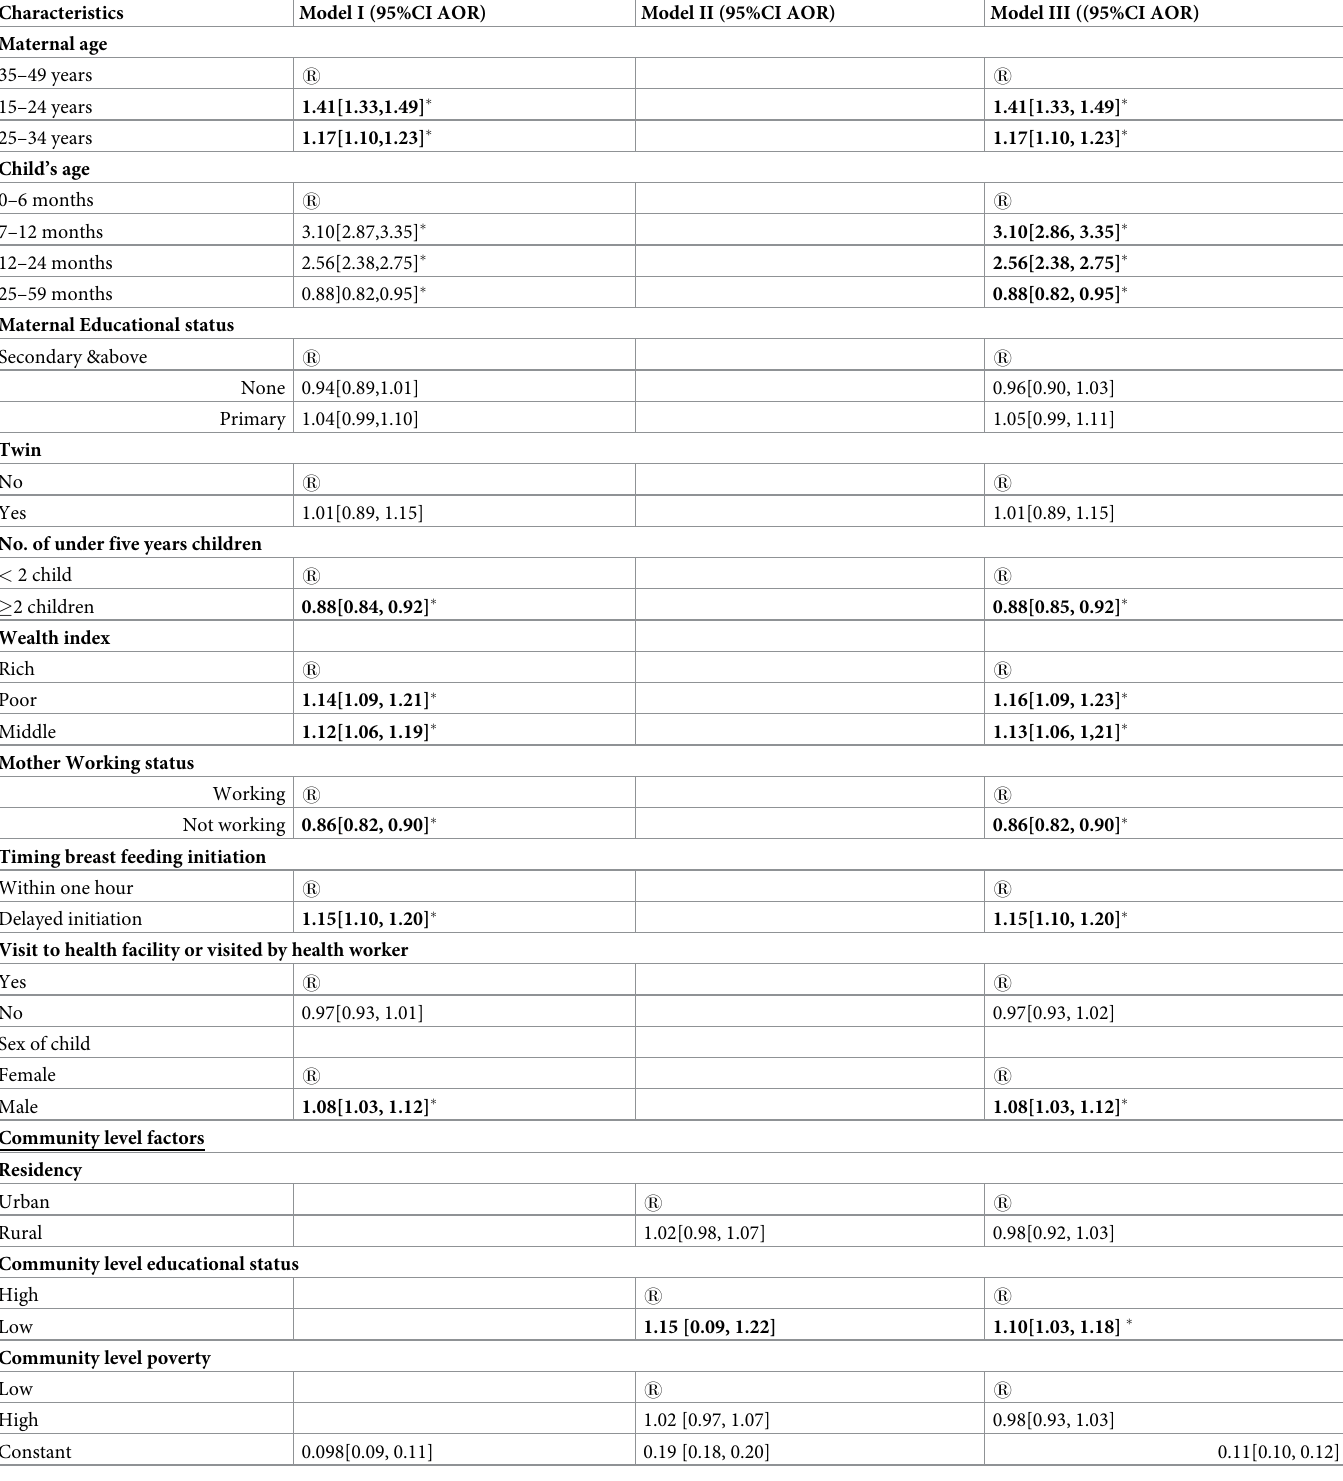
Table 5. Multivariable multilevel logistic analysis result of diarrhea diseases among under five years children in East African countries.